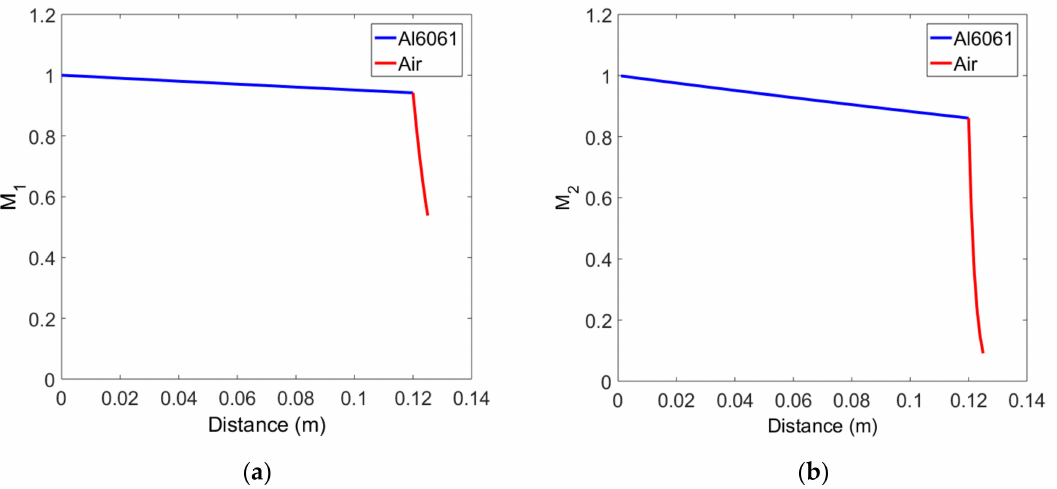
Figure 4. Variation of attenuation correction in the two-layer medium of solid-air: ( a ) Fundamental wave, and ( b ) Second harmonic